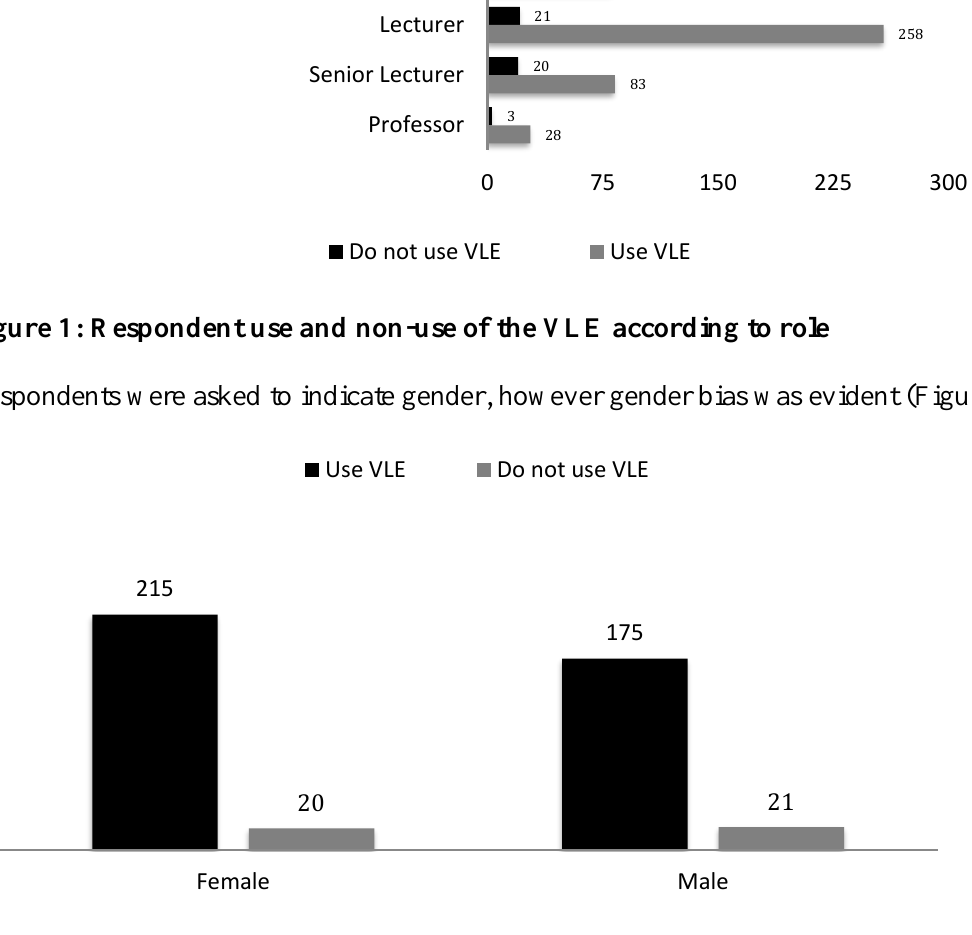
Figure 2: Use and non-use by gender When asked to indicate how long respondents have been using the VLE, 44% reported using the VLE for more than five years, (n=200) with a further 38% indicating usage for two years or more and 18% (n=80) reporting using it for less than two years (Figure